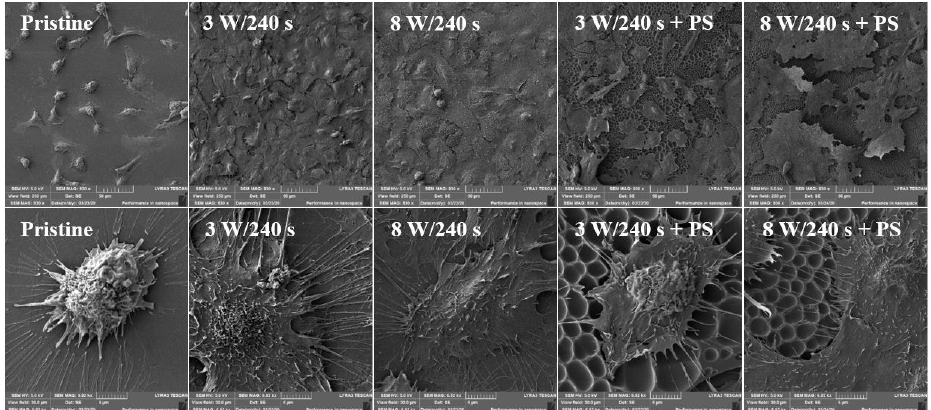
Figure 11. Scanning electron microscopy images of human osteoblasts (U-2 OS) at 6 days post-seeding on FEP (pristine), FEP matrices treated using plasma with 3 W and 8 W (240 s) and subsequently coated with a honeycomb-like pattern formed from PS. The upper line represents a 250 × 250 µm 2 scan, the bottom line a detailed scan with an area of 30 × 30 µm 2 .